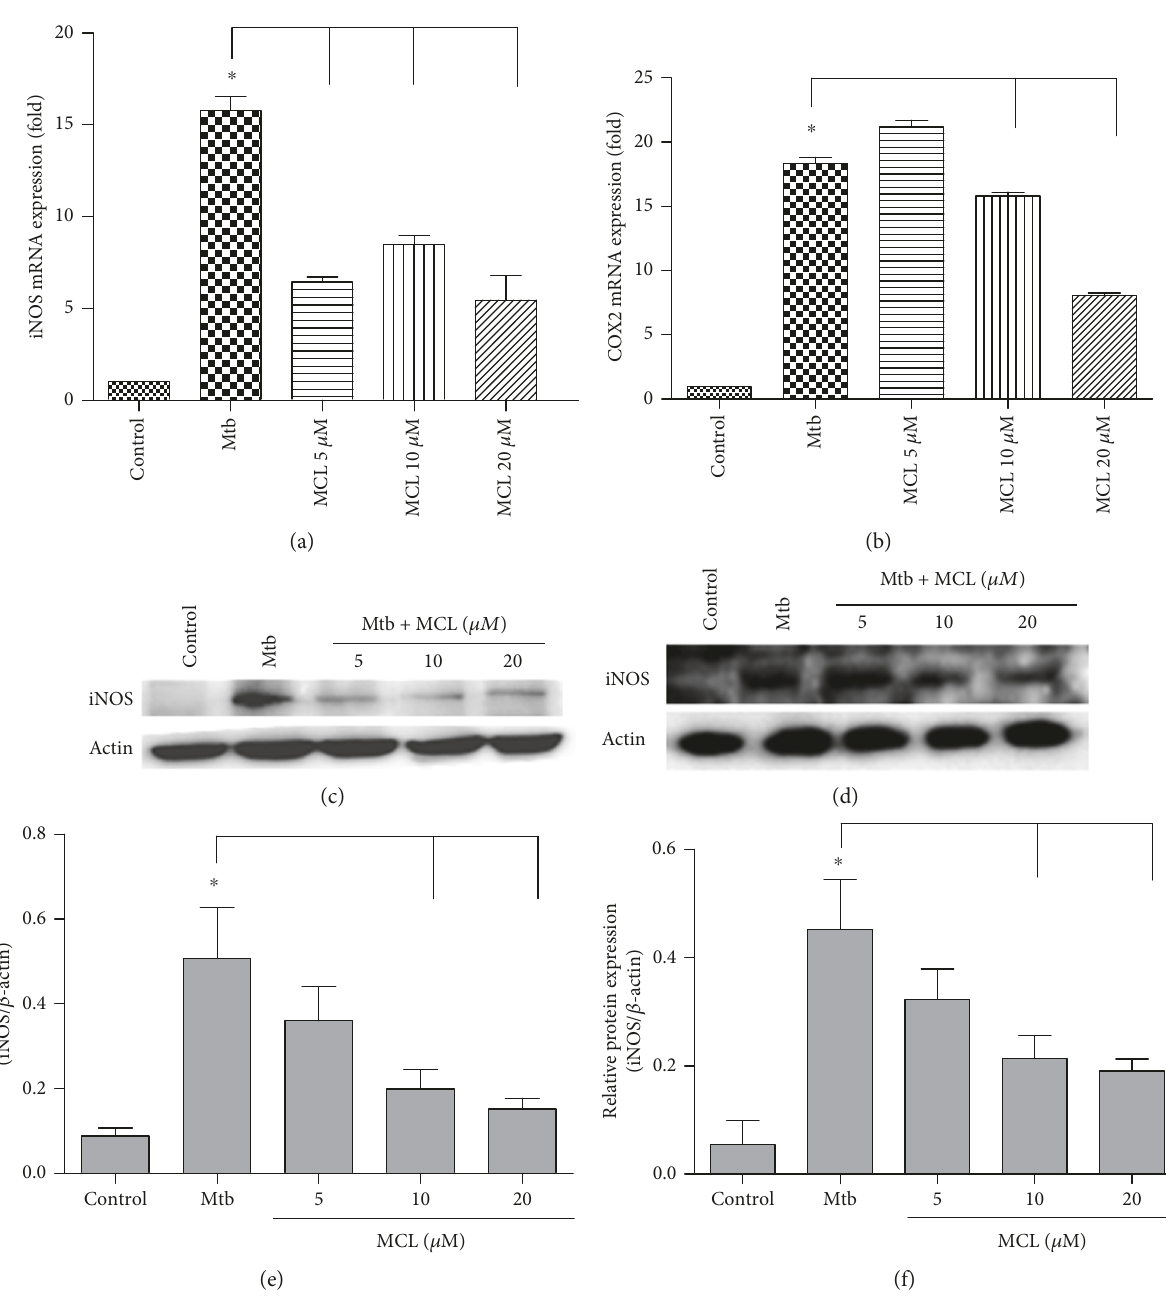
Figure 2: MCL suppresses the expression of iNOS and COX2 induced by Mtb infection both at transcriptional and at translational levels. Raw264.7 cells (1 × 10 6 /well) were seeded in 6-well plates overnight. Four hours after infected with H37Ra at MOI of 10, cells were washed with PBS and treated with di ff erent concentration of MCL (5, 10, and 20 μ M) for 12hr. The mRNA expression of iNOS (a) and COX2 (b) was detected by qRT-PCR. Data are shown as the means ± SD ( n ≧ 3 ). ∗ p < 0 05 .The protein levels of iNOS (c) and COX2 (d) were detected by Western blot, and β -actin was used as an internal control. (e) and (f) showed the statistical results for iNOS and COX2 expression. Data were presented as mean ± SD in at least three independent experiments. ∗ p < 0 05